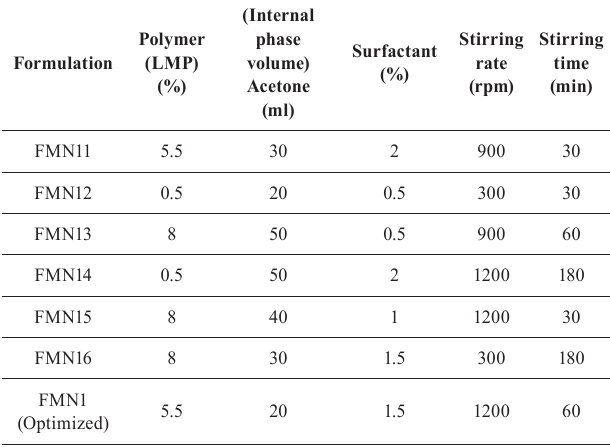
TABLE I - T aguchi orthogonal array design in different